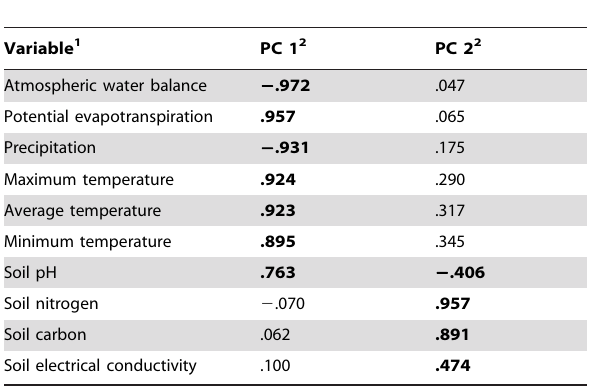
Table 2. Component loadings of ten variables based on principal components analysis of site-level climatic and soil